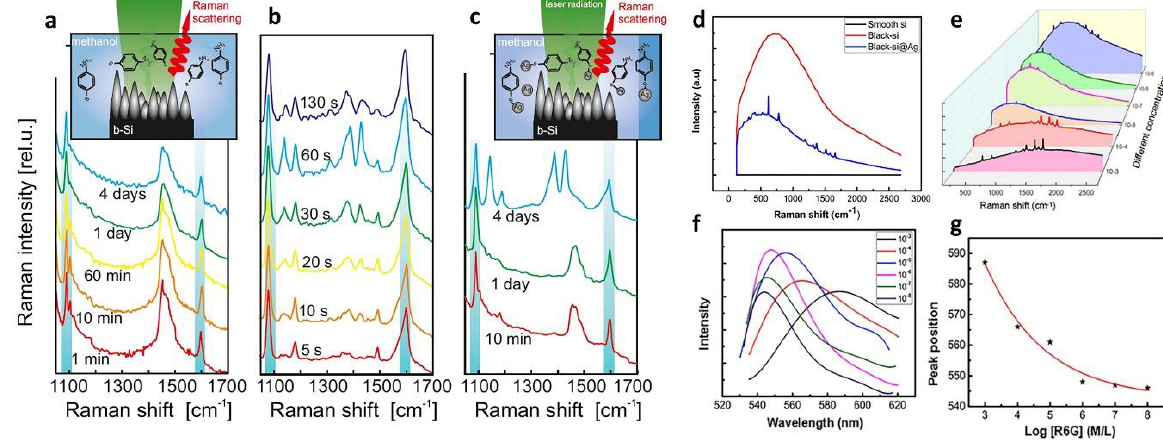
Figure 12. Application of black silicon in surface-enhanced Raman scattering (SERS). ( a – c ) detected PATP-to-DMAB photocatalysis conversion using different bare or Ag-coated black silicon with or without laser radiation in the aqueous methanol solution. Adapted from reference [103]. ( a ) Bare black silicon without laser radiation. ( b ) Ag-coated black silicon without laser radiation. ( c ) Bare black silicon without laser radiation. ( d – g ) Performances of R6G concentration detector based on black silicon. Adapted from reference [107], with permission from Elsevier © 2020. ( d ) Sensitivity of black-silicon SERS substrate. ( e ) Original SERS spectrum of different R6G concentration. ( f ) Fluorescence spectra of different concentrations of R6G. ( g ) The corresponding R6G sensor calibration diagram drawn by different fluorescence peaks.